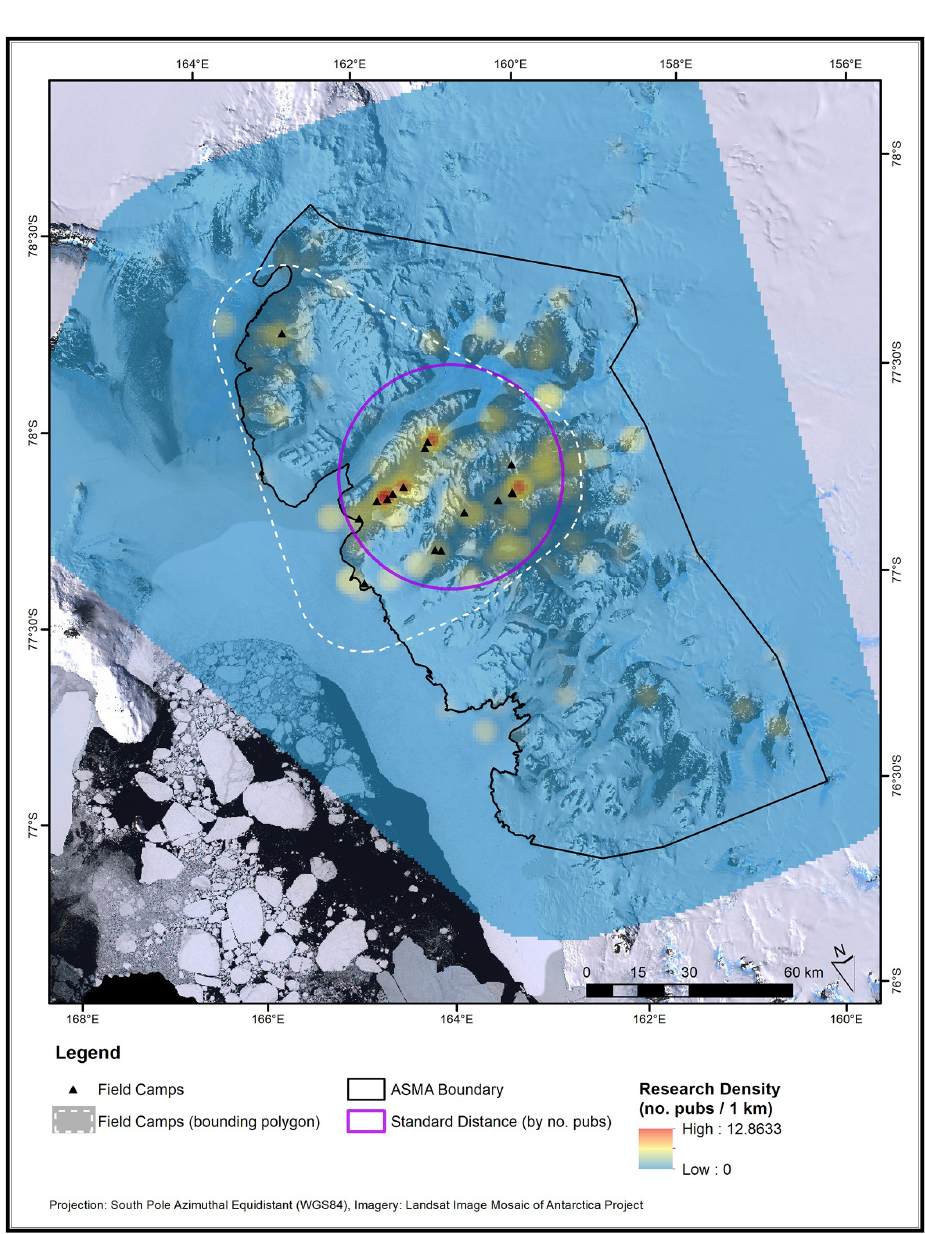
Fig 4. Hotspots (density), and standard distance (dispersion) of scientific field studies in the McMurdo Dry Valleys from 1907–2016. The minimum bounding polygon for all historic and current field camps (with 20 km buffer), and the McMurdo Dry Valleys Antarctic Specialty Managed Area (ASMA) boundary are included for reference. Note that the density surface is displayed with a stretch (gamma = 4) to highlight mid-range values. An animation showing these data through time is available in the S1